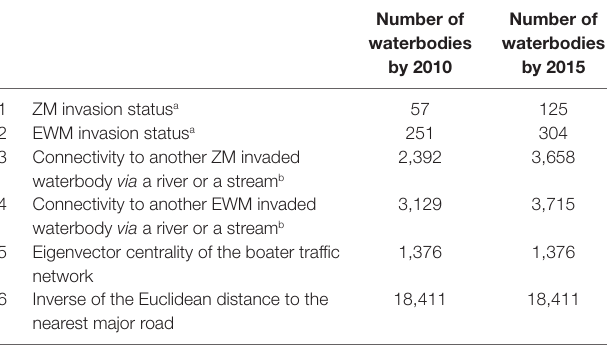
TaBle 1 | Number of waterbodies with the characteristic of each variable by 2010 and 2015.